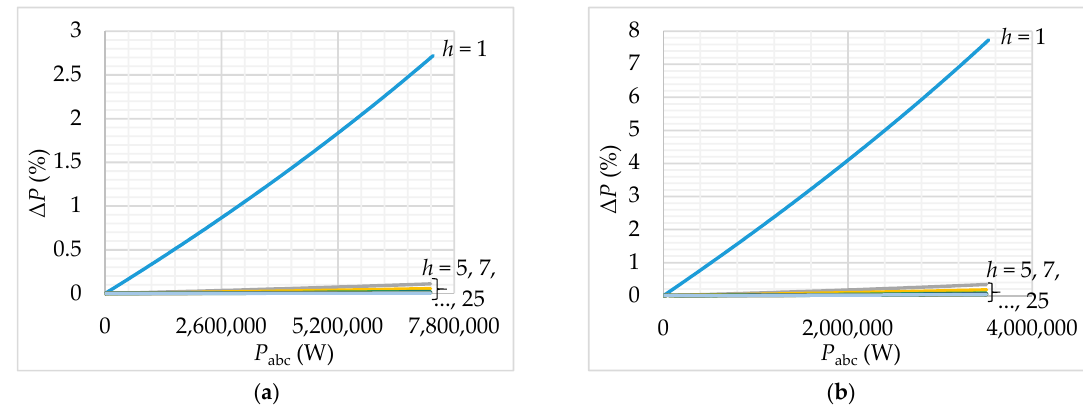
Figure 17. Distribution grid for the analysis of the influence of individual factors. Figure 17. The dependence of increasing APLs from three-phase active power consumption for ACSR 95 / 15: ( a ) the length of 5 km; ( b ) the length of 30 km.